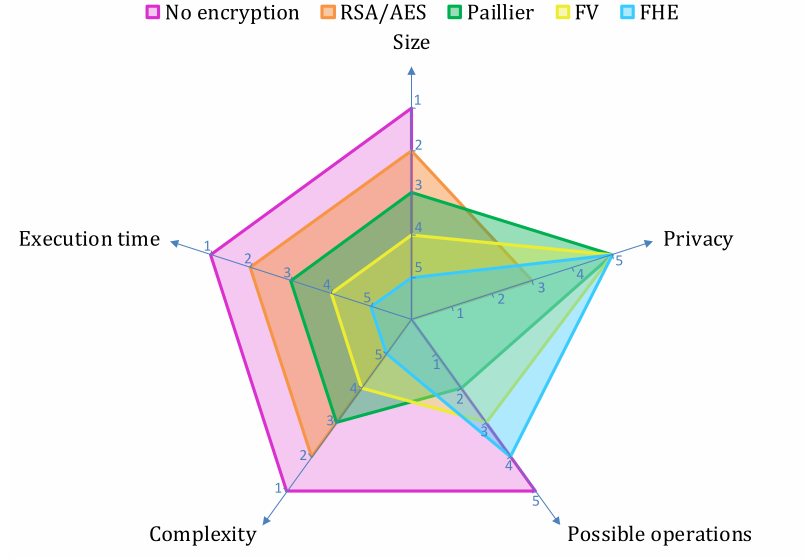
Figure 5. Comparison of different encryption